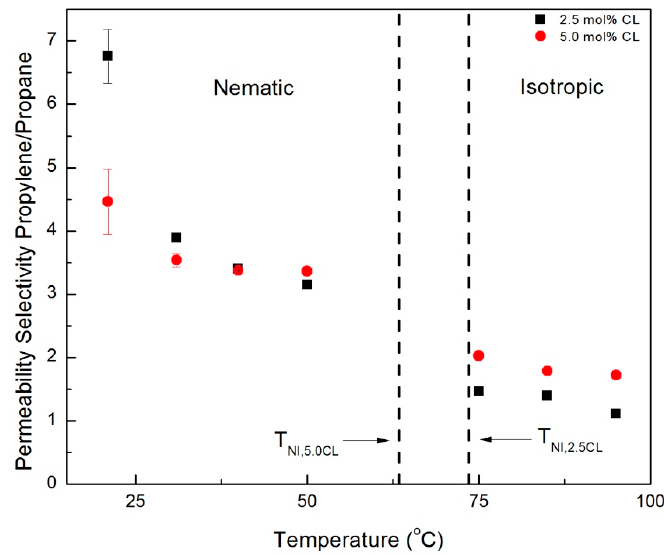
Figure 8. Diffusivity of various gases in the CNBPh75_5.0 membrane (5.0% crosslinker) in the nematic and isotropic phases. The dashed line indicates the nematic–isotropic transition temperature. An expanded view of the nematic region is given in the supporting information.